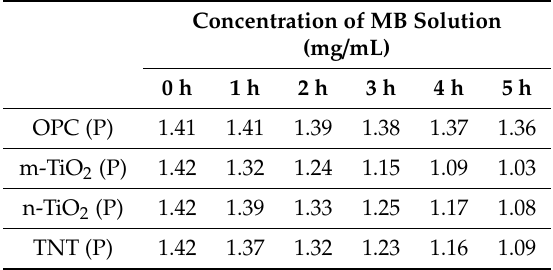
Figure 11. ( a ) Normalized concentration of MB solution with cement paste containing photocatalysts and ( b ) the color change of the MB solution. Table 6. The decomposition of MB solution with cement paste samples.